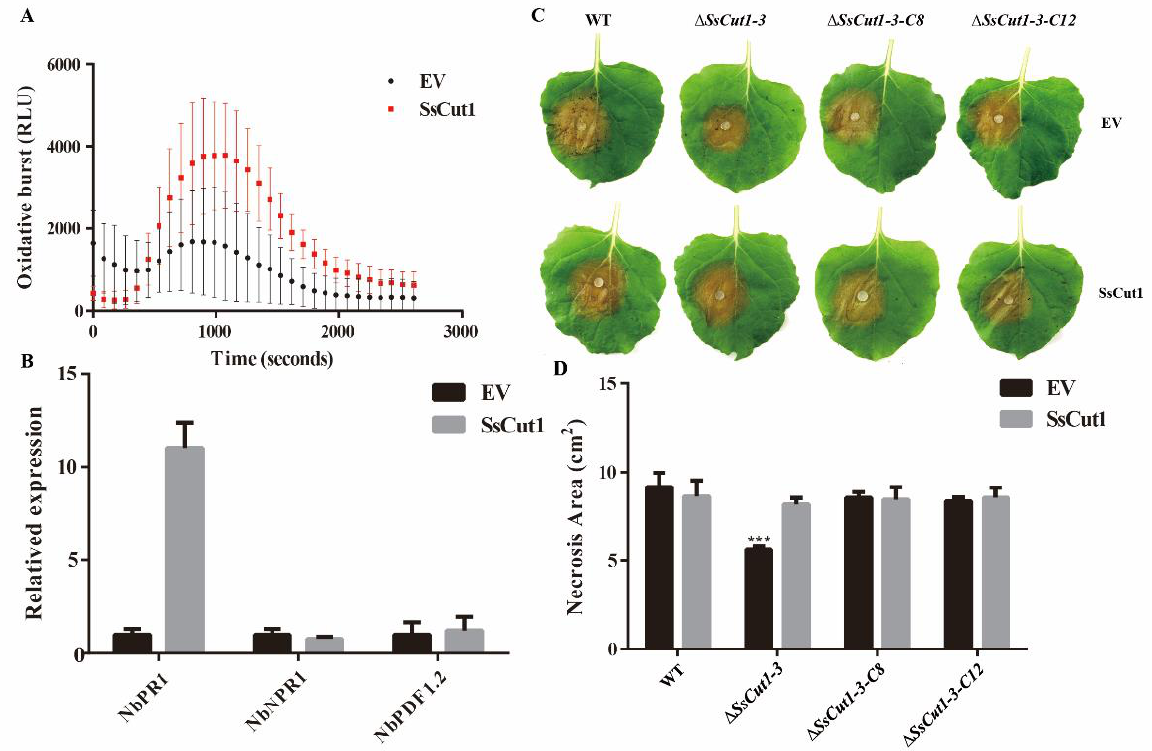
Figure 7. SsCut1 triggers plant defense responses and plays a role in the Sclerotinia – plant interac- tion. ( A ) SsCut1 promote flg22-triggered reactive oxygen species burst. The N. benthamiana with SsCut1 and empty vector were treated with 100 µg/mL flg22. Bars indicate ± SE. Error bars represent